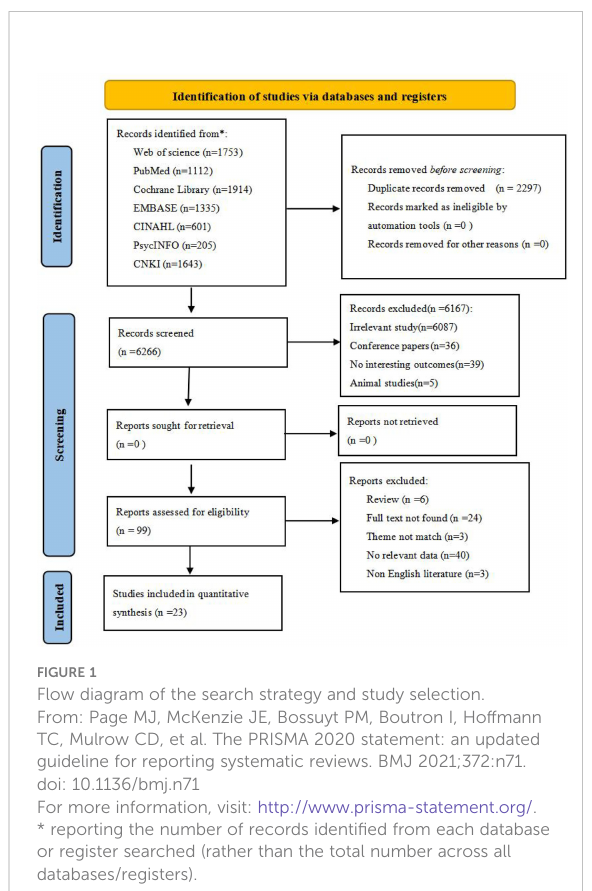
FIGURE 1 Flow diagram of the search strategy and study